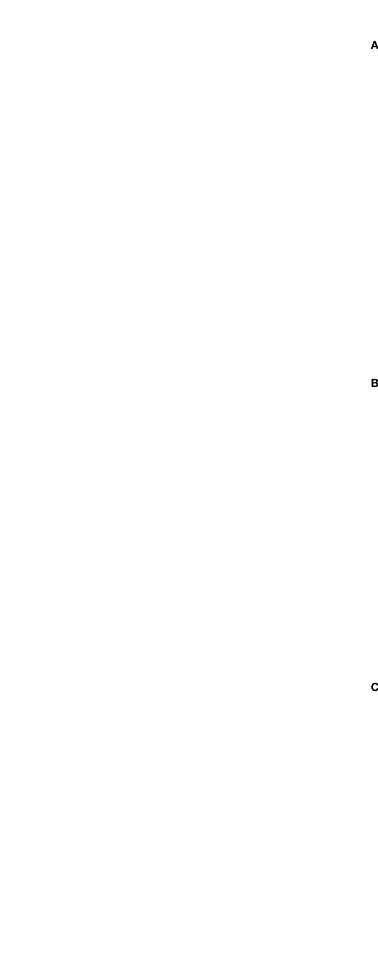
FIGURE 3 | (A) Least square means of BMI z-score by the level of nutrition adherence with 95% con fi dence interval and trend analysis adjusted for age, sex, and race. To compare means of BMI z-score by nutritional adherence levels, a generalized linear model was performed on BMI z-score measured over time (baseline, year 1, and year 2). The dependent variable BMI z-score for the model was assumed to be normally distributed. Generalized Estimating Equations (GEE) was applied to account for possible autocorrelations between repeated measures. Independent variables for the model included time, nutritional adherence level (adherent vs. non-adherent), an interaction term between time and nutritional adherence level, adjusted for age, sex, and race/ethnicity. This fi gure shows the least-square estimated means of BMI z-score over time, strati fi ed by nutritional adherence level with 95% con fi dence. There was a signi fi cant difference in the overall mean BMI z-score between the 2 groups, with the adherent group having higher BMI z-scores compared to the non-adherent group (p=0.003). Scheffe ́ ’ s multiple comparisons showed that the adherent group had higher BMI z-score at baseline (p=0.002) and year 2 (p=0.001), but not at year 1 (p=0.13) when compared to the non-adherent group. There was no signi fi cant difference in the BMI z-score trend between the 2 groups (p=0.66). Scheffe ́ ’ s multiple comparisons showed no changes in BMI z-score between consecutive time points at the group level: p=0.20 from baseline to year 1, and p=0.60 from year 1 to year 2 for the adherent group. Corresponding p values for the non-adherent group were 0.99 and 0.91, respectively. (B) Least square means of BMI by the level of nutrition adherence with 95% con fi dence interval and trend analysis adjusted for age, sex, and race. To compare means of BMI by nutritional adherence levels, a generalized linear model was performed on BMI measured over time (baseline, year 1, and year 2). The dependent variable BMI for the model was assumed to be normally distributed. Generalized Estimating Equations (GEE) was applied to account for possible autocorrelations between repeated measures. Independent variables for the model included time, nutritional adherence level (adherent vs. non-adherent), an interaction term between time and nutritional adherence level, adjusted for age, sex, and race/ethnicity. This fi gure shows the least- square estimated means of BMI over time, strati fi ed by nutritional adherence level with 95% con fi dence. There was a signi fi cant difference in the overall mean BMI between the 2 groups, with the adherent group having a higher BMI compared to the non-adherent group (p=0.049). Scheffe ́ ’ s multiple comparisons showed that the adherent group had higher BMI at baseline (p=0.045) and year 2 (p=0.03), but not at year 1 (p=0.20) when compared to the non-adherent group. There was no signi fi cant difference in the BMI trend between the 2 groups (p=0.58). Scheffe ́ ’ s multiple comparisons for the adherent group showed no changes in BMI between baseline and year 1 (p=0.94), but a signi fi cant change between years 1 and 2 (p=0.01). There was no signi fi cant change in BMI between consecutive time points for the non-adherent group. (C) Least square means of weight by the level of nutrition adherence with 95% con fi dence interval and trend analysis adjusted for age, sex, and race. To compare means of weight by nutritional adherence levels, a generalized linear model was performed on weight measured over time (baseline, year 1, and year 2). The dependent variable weight for the model was assumed to be normally distributed. Generalized Estimating Equations (GEE) was applied to account for possible autocorrelations between repeated measures. Independent variables for the model included time, nutritional adherence level (adherent vs. non-adherent), and an interaction term between time and nutritional adherence level, adjusted for age, sex, and race/ethnicity. This fi gure shows the least-square estimated means of weight over time, strati fi ed by nutritional adherence level with 95% con fi dence. There was no signi fi cant difference in the overall mean weight between the two groups (p=0.17). Scheffe ́ ’ s multiple comparisons showed no signi fi cant difference in mean weight at each time point either. A signi fi cant change in mean weight was seen from year 1 to year 2 in the adherent group (p<0.0001), and from baseline to year 1 in the non-adherent group